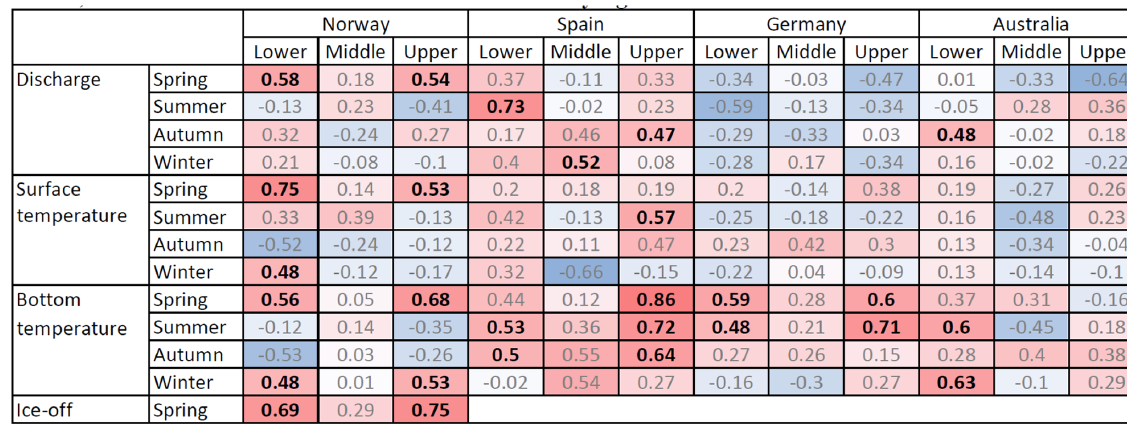
Table 6. SEAS5 meteorological and Lake_F lake hindcasts associated with statistically significant FRPSS or ROCSS values in each case study.